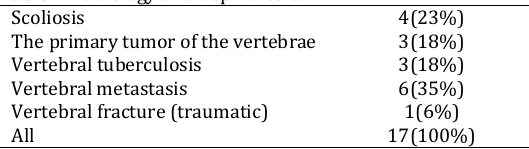
Table5. Level affected Single